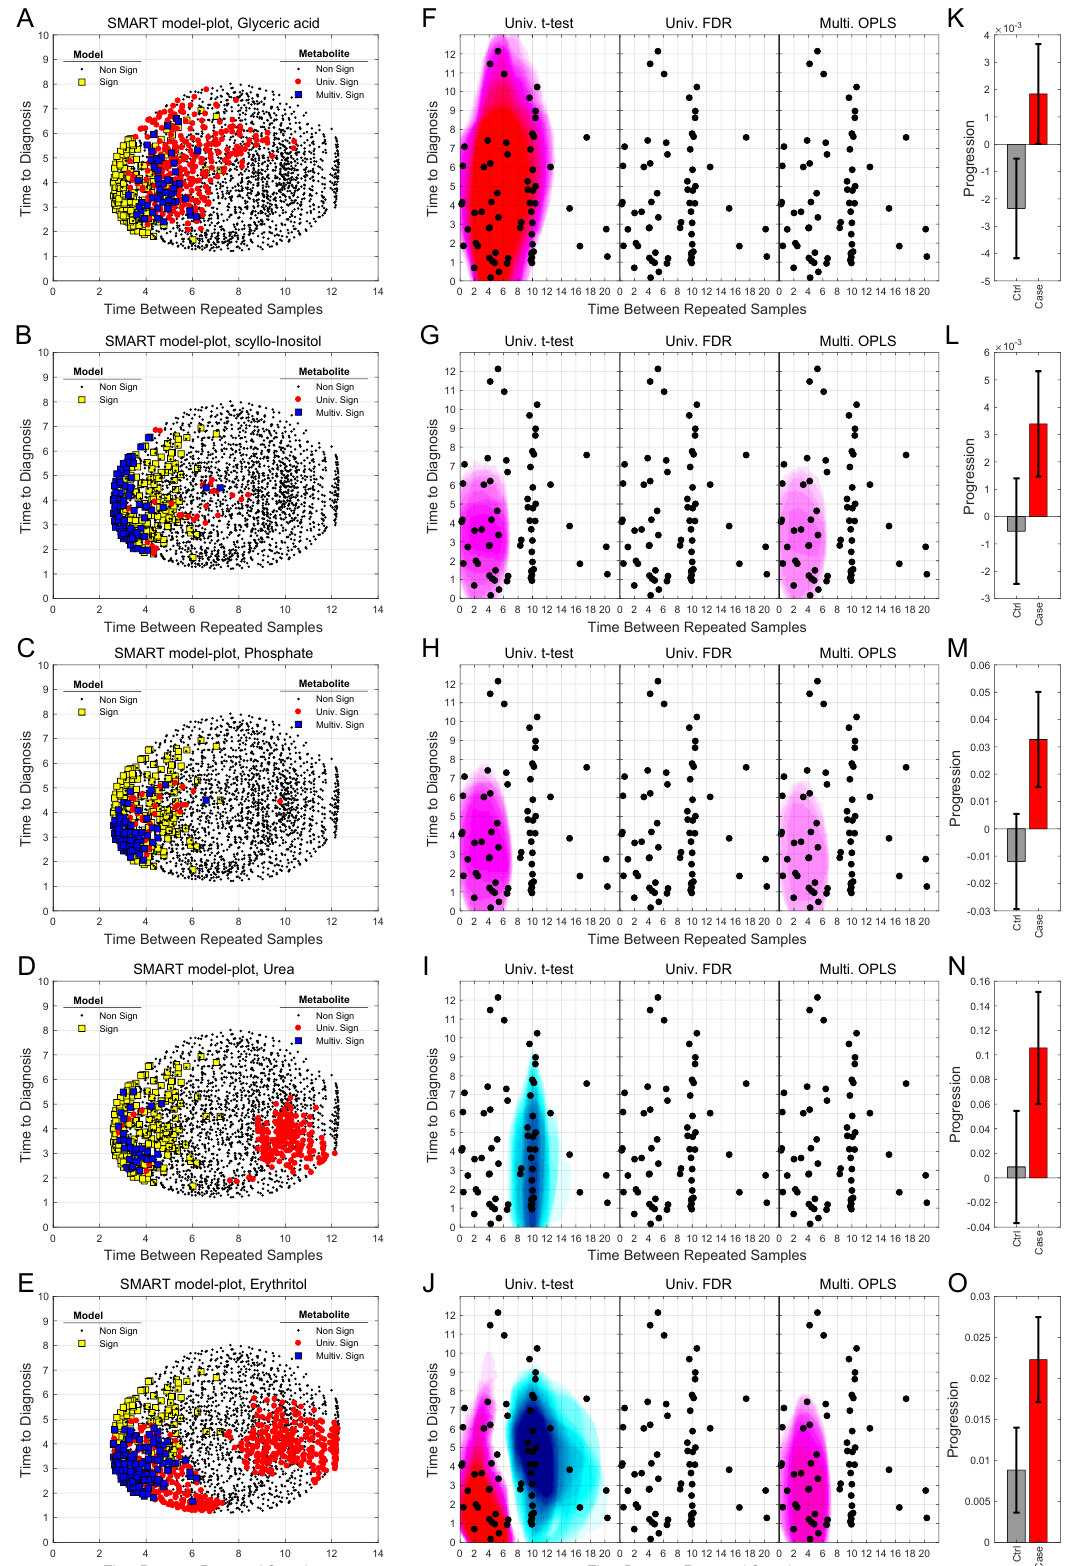
Figure 5. SMART-model and SMART-observation plots, and progression patterns for individual metabolites: glyceric acid ( A , F , K ), scyllo-inositol ( B , G , L ), phosphate ( C , H , M ), urea ( D , I , N ) and erythritol ( E , J , O ). ( A – O ) As described in figure legend